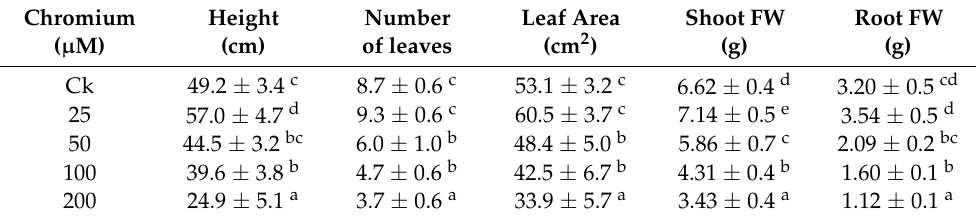
Table 1. Impact of Cr treatments on growth parameters of sweet potato.